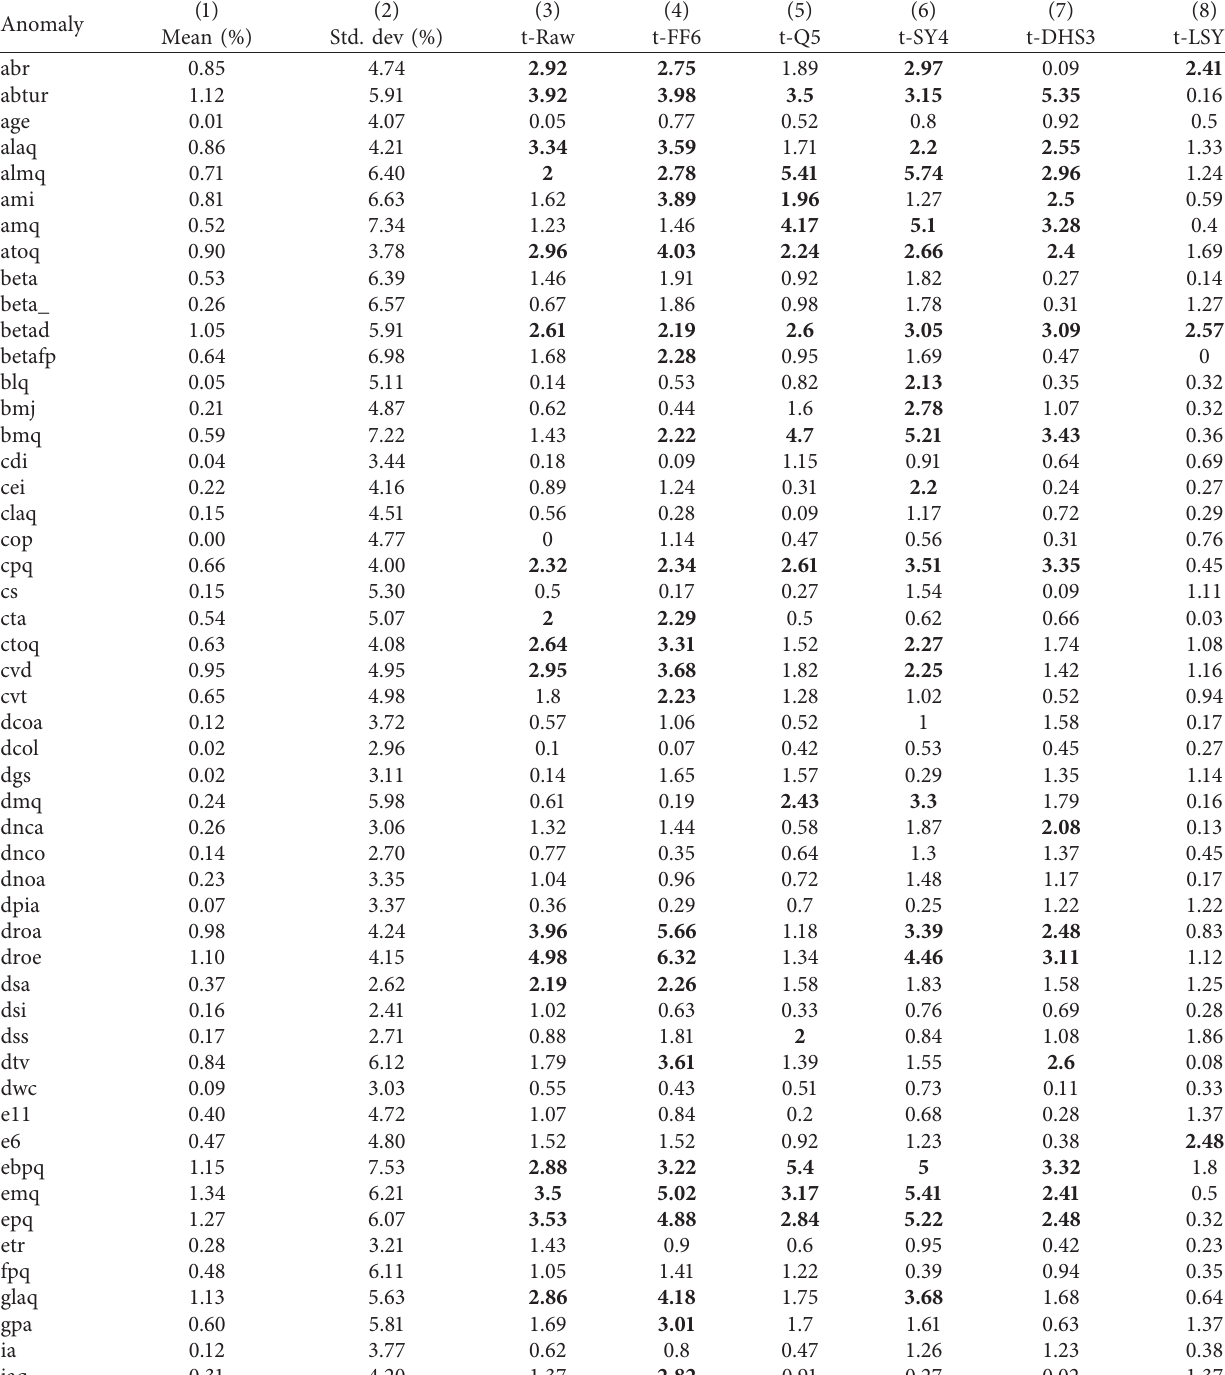
Table 4: Anomalies by univariate characteristic sorting. This table displays the return properties of anomalies constructed by sorting on each of the 104 characteristics over the whole sample of July 2000 to December 2019. With monthly rebalancing, we sort all stocks by individual characteristics into 10 deciles, form value-weighted portfolio within each decile, and build a long-short spread portfolio using decile ten and one. For each portfolio, we report the monthly return means, standard deviations, and t -statistics in columns labeled “Mean,” “Std. dev,” and “t-Raw.” We also use various factor models to explain these anomalies and report corresponding t -statistics of alphas with Newey–West adjustment over 12 monthly lags, including the Fama–French 6-factor model [10], the Hou–Xue–Zhang q5-factor model [2], the Stambaugh–Yuan 4-factor model [21], the Daniel–Hirshleifer–Sun 3-factor model [22], and the Liu–Stambaugh–Yuan 4-factor model [15], in columns “t-FF6,” “t-Q5,” “t-SY4,” “t-DHS3,” and “t-LSY4,” respectively. Bold types denote values that are statistically significant at 95%